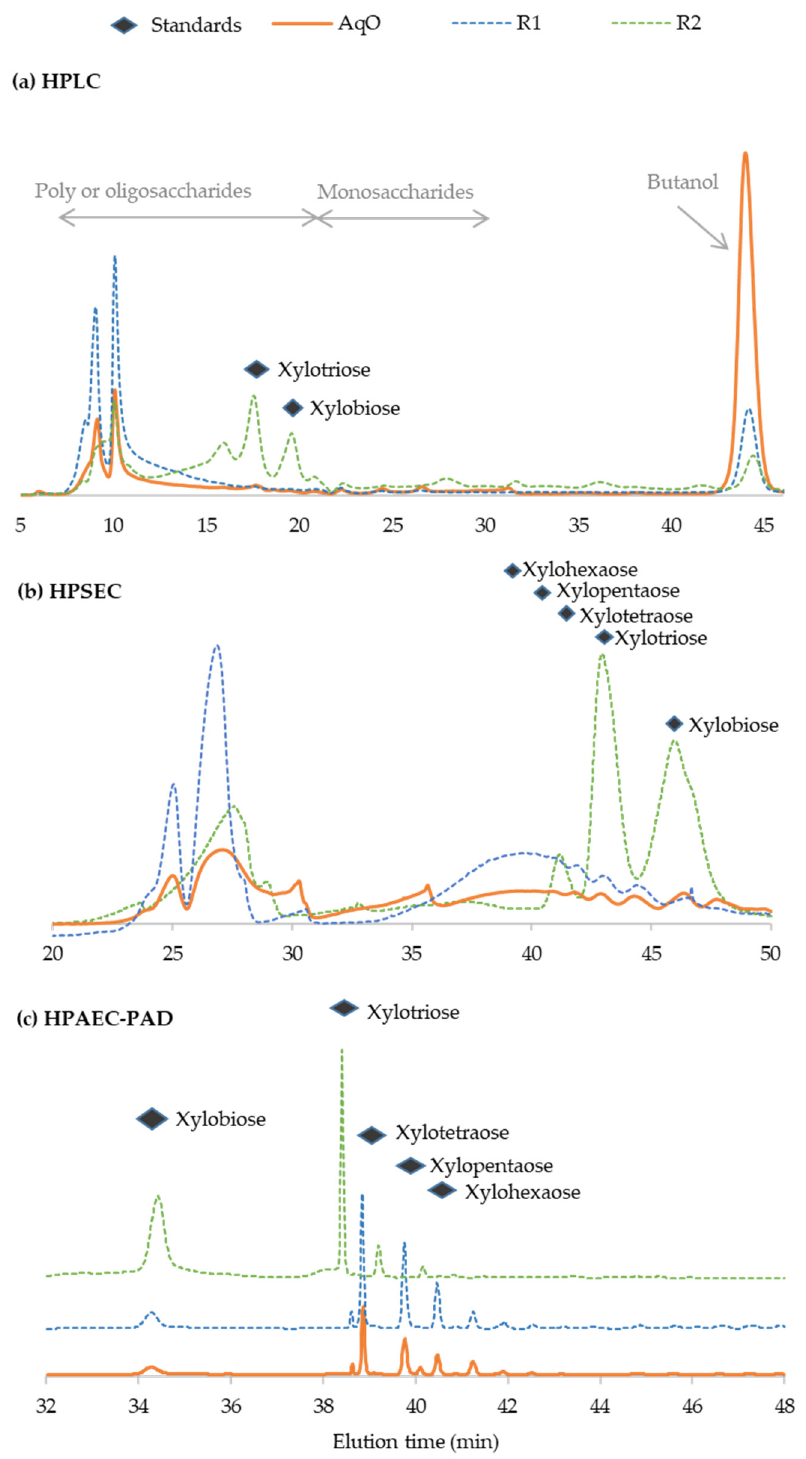
Figure 6. Elution profiles obtained for streams AqO, R1 and R2 and standard XOS using: ( a ) HPLC (with the CARBOSep column); ( b ) HPSEC; and ( c ) HPAEC-PAD. In the HPLC chromatograms (Figure 6a), the monosaccharides appeared at retention times between 20 and 28 min. The peaks eluted at shorter times corresponded to com- pounds included in the OS fraction, in order of decreasing DP. For comparison, the Figure